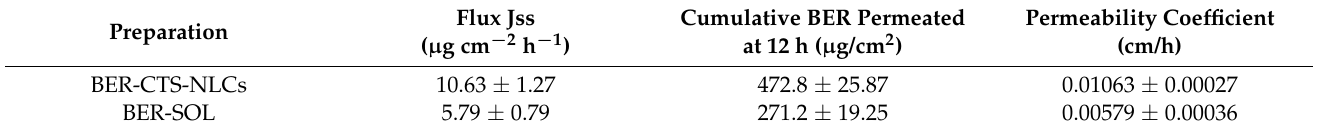
Table 4. Ex vivo permeation parameters of BER-CTS-NLCs vs.